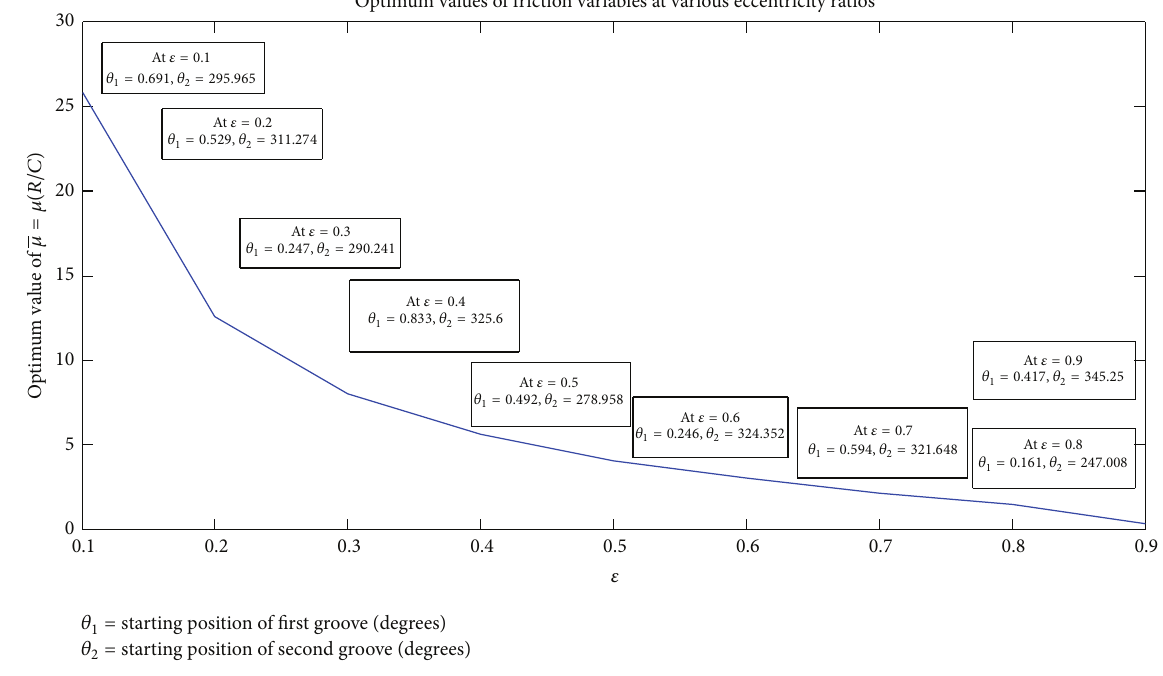
Figure 11: Variation of friction variable at optimum grooving location for different 𝜀 .